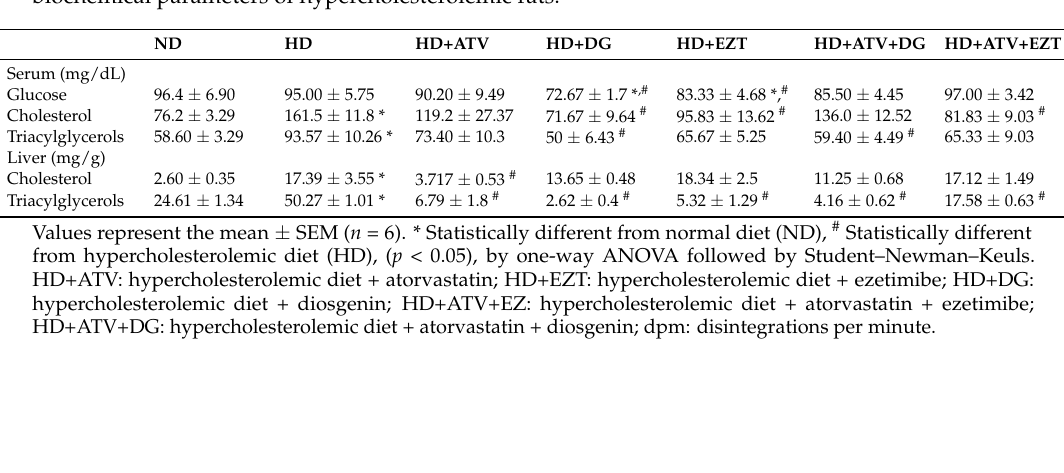
Table 1. Effect of atorvastatin, ezetimibe, and diosgenin or their combination on serum and liver biochemical parameters of hypercholesterolemic rats.